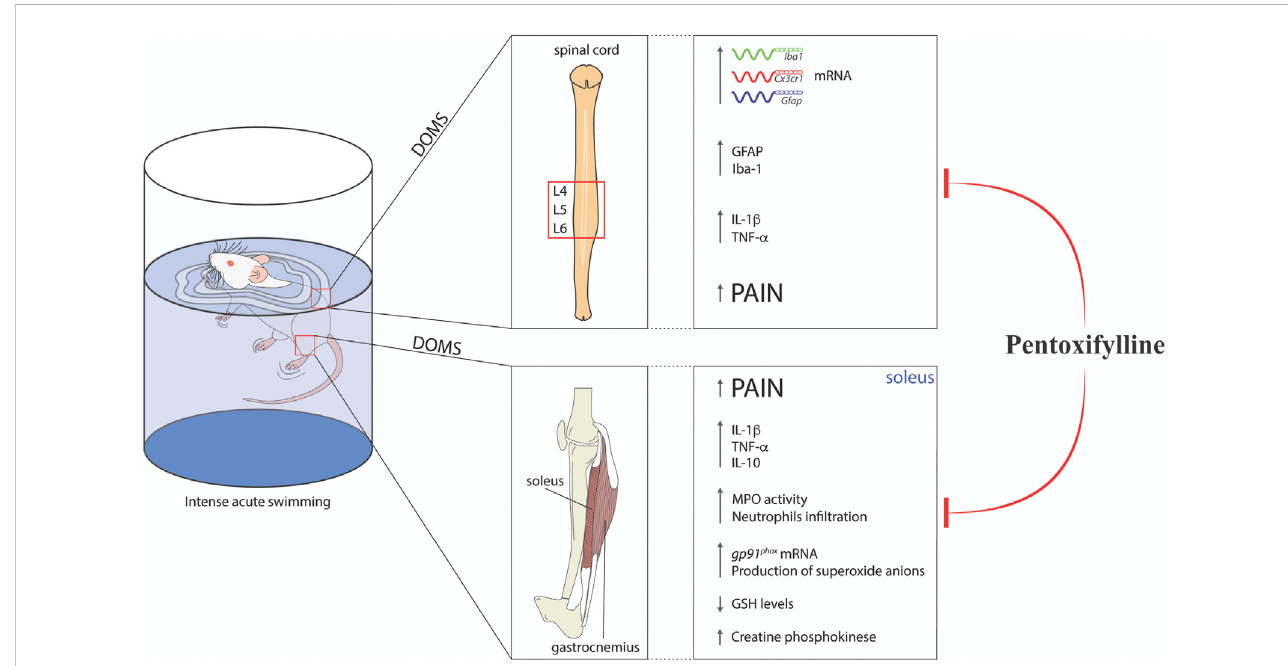
FIGURE 4 Schematic representation of pentoxifylline modulatory mechanisms in experimental DOMS in mice. Ptx treatment reduced DOMS CK elevation, neutrophils recruitment, oxidative stress (increased gp91 phox mRNA expression and superoxide anion production and reductions in GSH levels), and cytokine production(TNF- α ,IL-1 β ,andIL-10 levels)inthesoleusmuscle. Inthespinal cord,Ptxtreatment inhibited cytokine production (TNF- α ,IL-1 β ,andIL-10 levels) and astrocytesand microglial activation at themRNA (Gfap, Iba1, and Cx3cr1)and protein (GFAP and Iba-1) levels. These integrated peripheraland spinal mechanisms lead to the reduction of muscle pain (DOMS) by Ptx